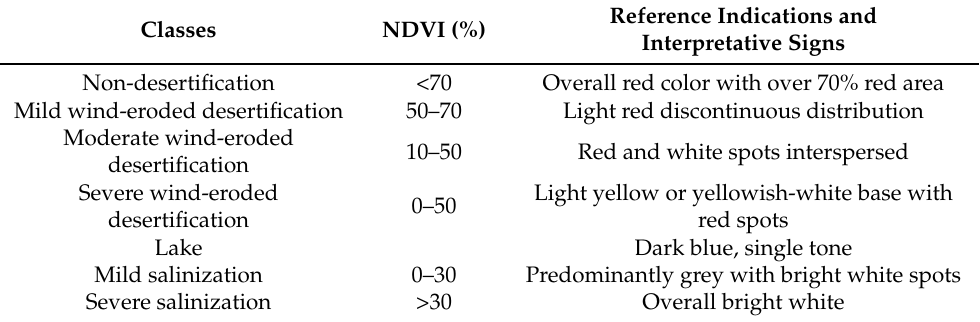
Table 8. Categories and features of surface features in study area. Classes NDVI (%)